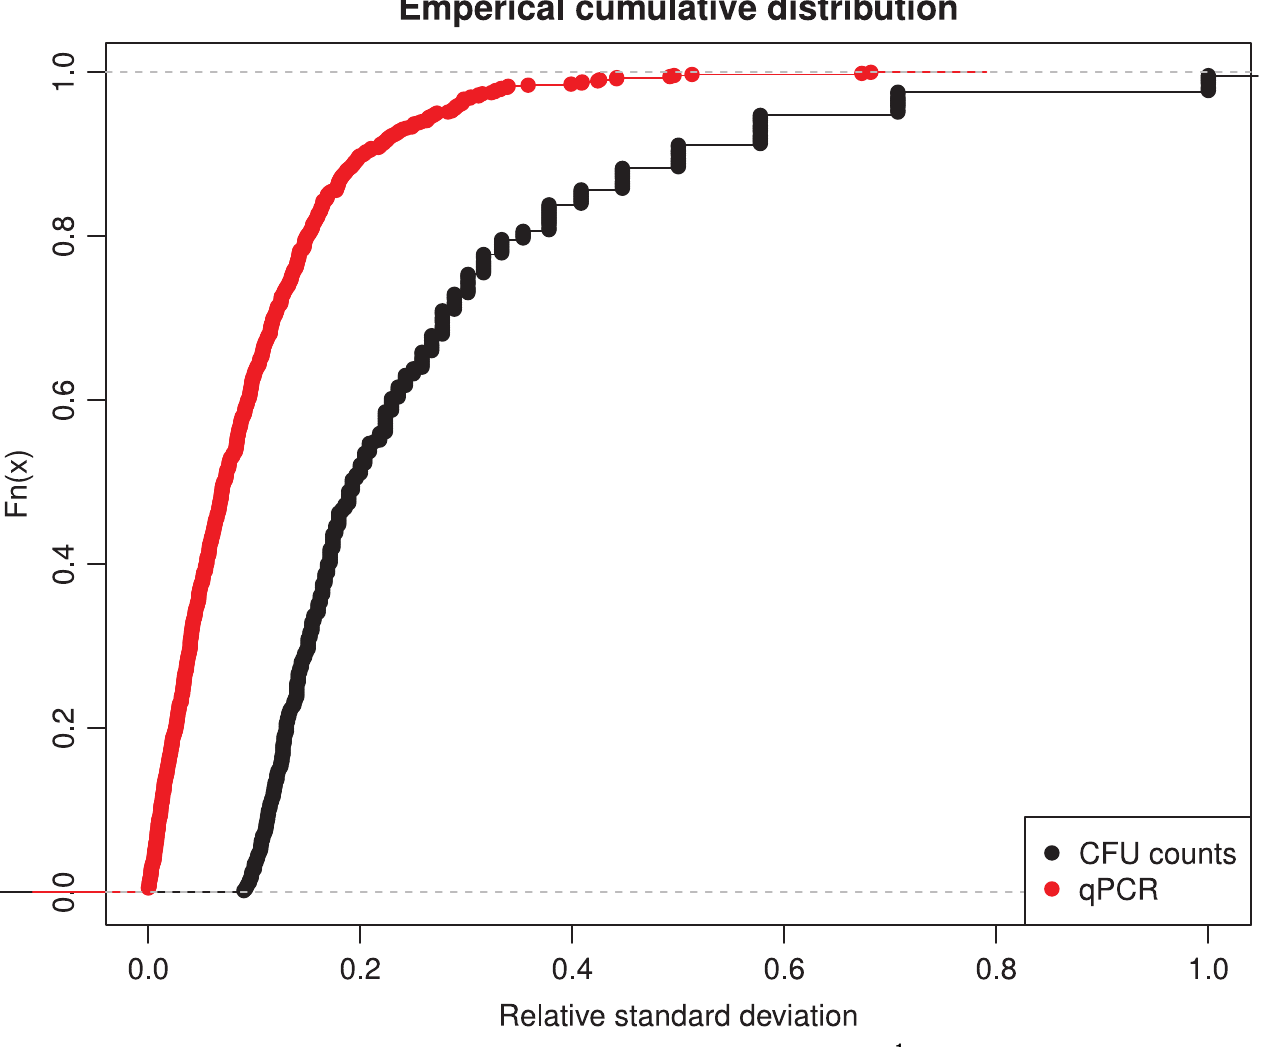
Fig 3. Relative standard deviations of the coliform CFU and qPCR gene copy number estimates g -1 feces. Empirical cumulative distribution (Fn(x)) plotted against the relative standard deviations of the CFU and gene copy number estimates illustrating the relationship between uncertainties of calculated estimates and the true laboratory determined estimates for CFU counts (black) and qPCR gene copy numbers (red),